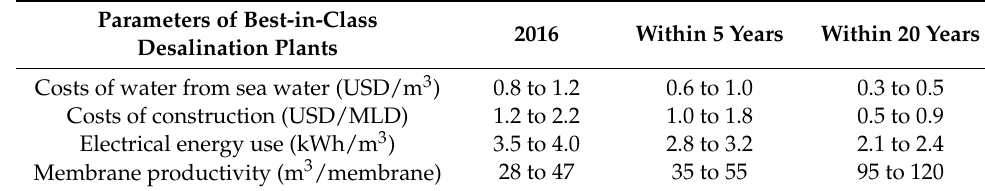
Table 2. Variations of costs for medium-size and large-size desalination projects (adapted from [89]). Parameters of